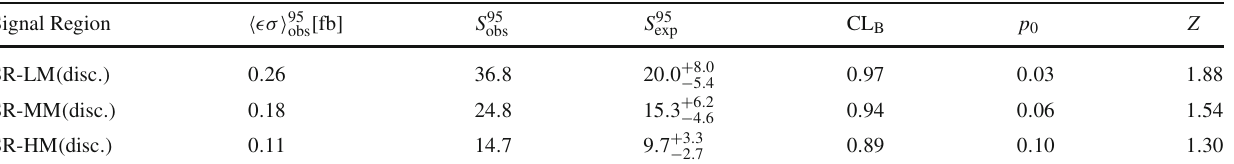
Table 6 Left to right: 95% CL upper limits on the visible cross-section three columns indicate the CL B value, i.e. the confidence level observed for the background-only hypothesis, the discovery p -value ( p 0 ) and the ( (cid:4) (cid:12)σ (cid:5) 95 ) and on the number of signal events ( S 95 ). The third column obs obs ( S 95 exp ) shows the expected 95% CL upper limit (and its ± 1 σ excursions) on the number of signal events if no BSM signal is present. The last